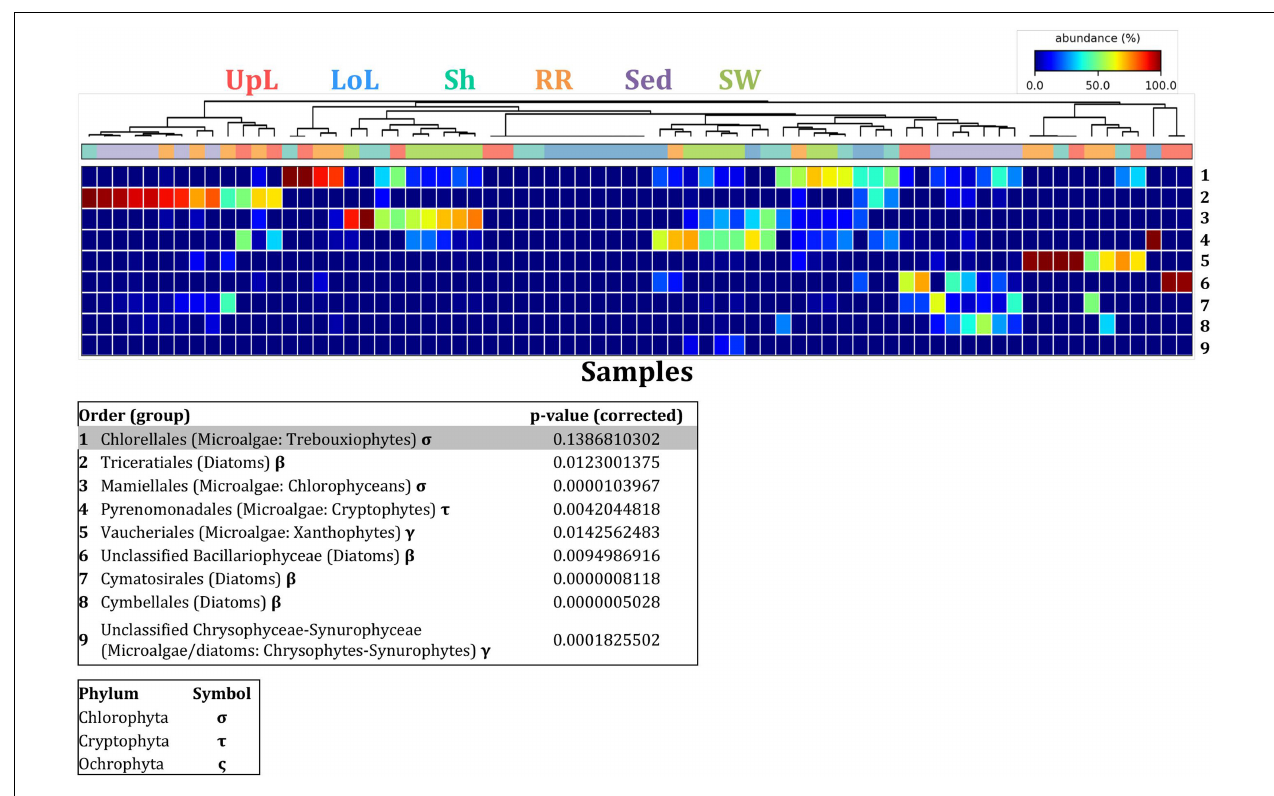
FIGURE 9 | Microalgal discriminatory OTUs at the microenvironmental scale. Extensive hypothesis testing of taxonomic profiles was coupled with similarity percentages analyses (SIMPER) for microalgal microbiomes across the six microenvironments. The proportion of sequences (mean frequency %) of OTUs significantly over-represented (Kruskal–Wallis H -test, α = 0.05, effect sizes: η 2 ) and consistently contributing to the differences between microenvironments is indicated by varying color intensities. Corrected p-values were calculated using the Benjamini–Hochberg’s approach. Two-way crossed SIMPER analyses were performed with site and microenvironment variables as factors (S17 Bray–Curtis similarity matrix). High contributors were selected from the top-5 contributors of each pair-wise comparison between microenvironments, and those OTUs consistently accounting for the dissimilarities between any given microenvironment and at least three other microenvironments were chosen as high contributors to couple with the statistical results. High contributors that were significantly over-represented were classified as discriminatory OTUs (i.e., 1–9). OTUs are sorted by decreasing mean abundance, and samples are clustered by average neighbor distance (UPGMA, distance threshold = 0.75) and colored by microenvironment. Different symbols represent the distribution of enriched phyla. High contributors that were not significantly over-represented (gray) were also classified as discriminatory OTUs if their contribution to the differences between microenvironments was consistent. UpL, upper leaf; LoL, lower leaf; Sh, sheath; RR, roots and rhizomes; Sed, sediment; SW,